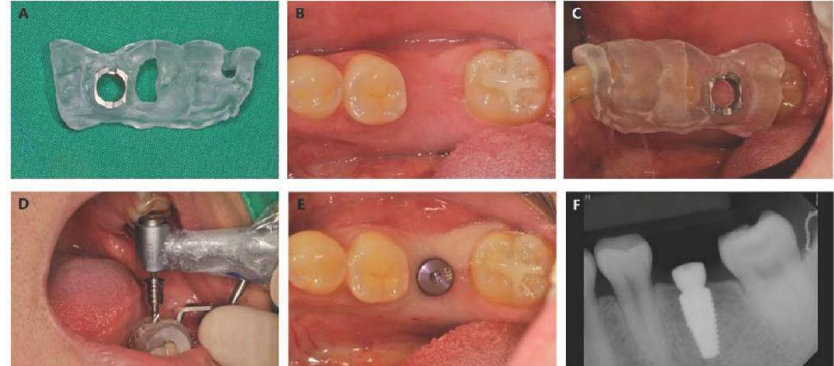
Figure 3. Representative photograph and radiograph of the implant surgery. ( A ) Clinical photograph of the surgical template, ( B ) clinical photograph before surgery, ( C ) placement of surgical template, ( D ) drilling procedure of flapless surgery, and ( E ) clinical photograph after implant placement. ( F ) Periapical radiograph after implant placement.